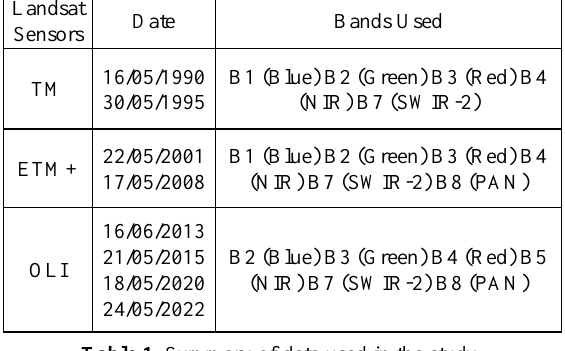
Table 1 . Summary of data used in the